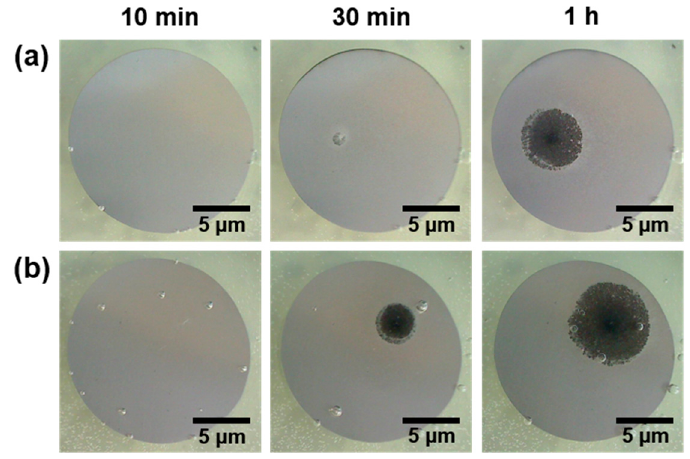
Figure 2. Optical micrographs showing the macroscopic surfaces of the extruded ( a ) ZK60 and ( b ) ZKC601 alloys after immersion for various times in 0.6 M NaCl solution at 25 ◦ C.